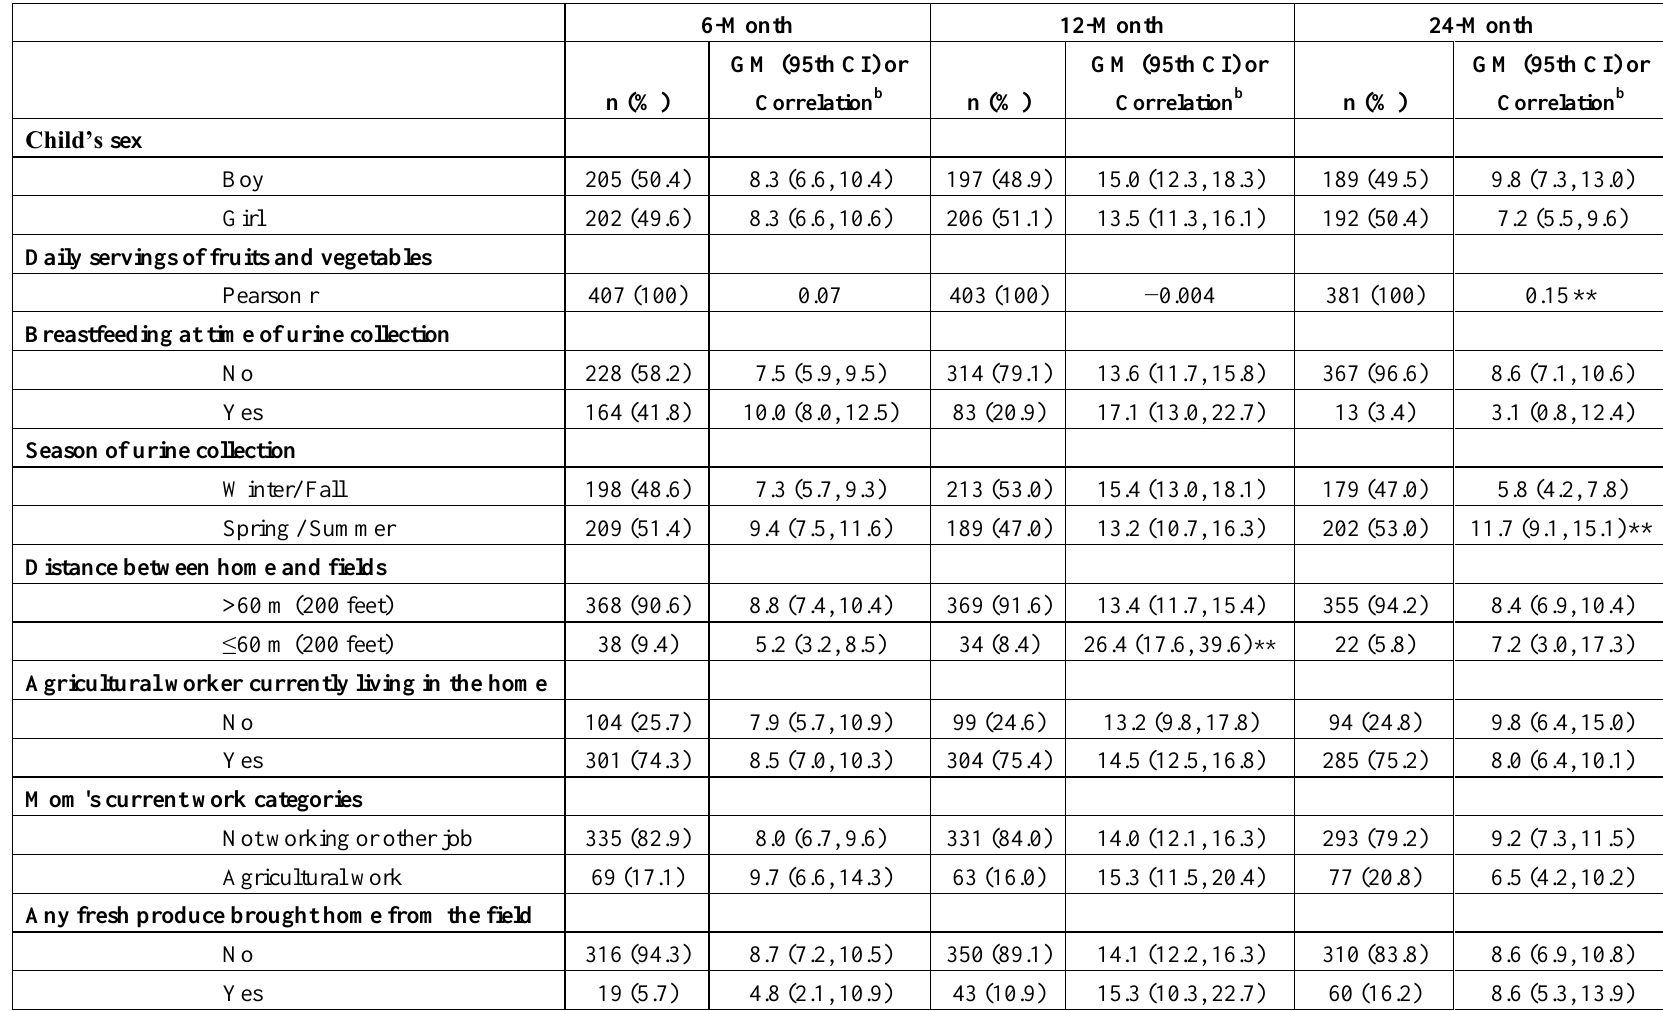
Table S4. Summary of children’s geometric mean DEAP urinary metabolite levels (nmol/L) and exposure prediction factors a